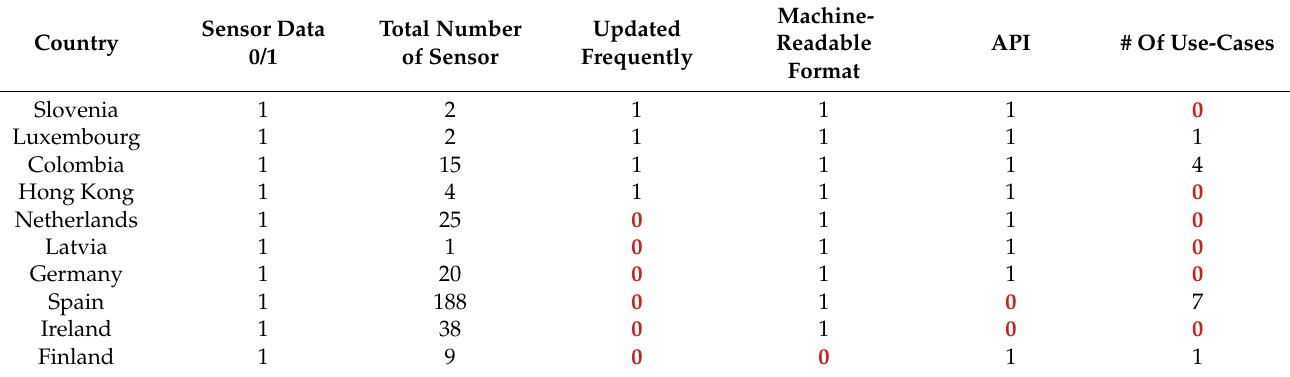
Figure 3. ( a ) Sensor data availability on 51 OGD portals; ( b ) Sensor data machine-readability; ( c ) Sensor data currency, i.e., frequency of updates. Table 7: TOP-10 OGD portals. Table 7. Sensor data: TOP-10 OGD